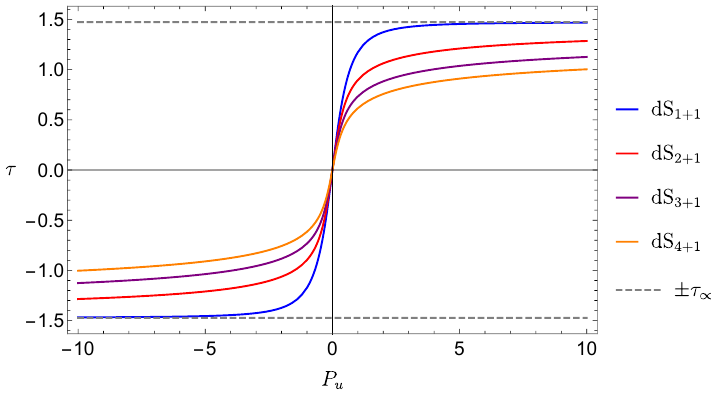
Figure 11 . Boundary times τ ( P u ) at various dimensional spacetime dS d +1 as a function of the conserved momentum P u . We take the stretched horizon located at ρ = 9 / 10 in this plot. The corresponding critical times ± τ ∞ are given by the limit | P u | → ∞ and denoted by the dashed